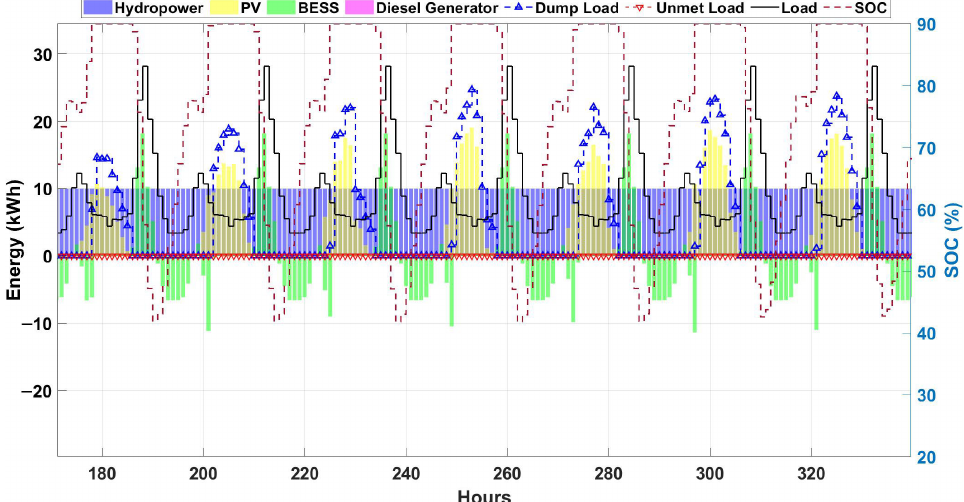
Figure 20. Energy scheduling—Scenario 2—no agricultural load and high solar